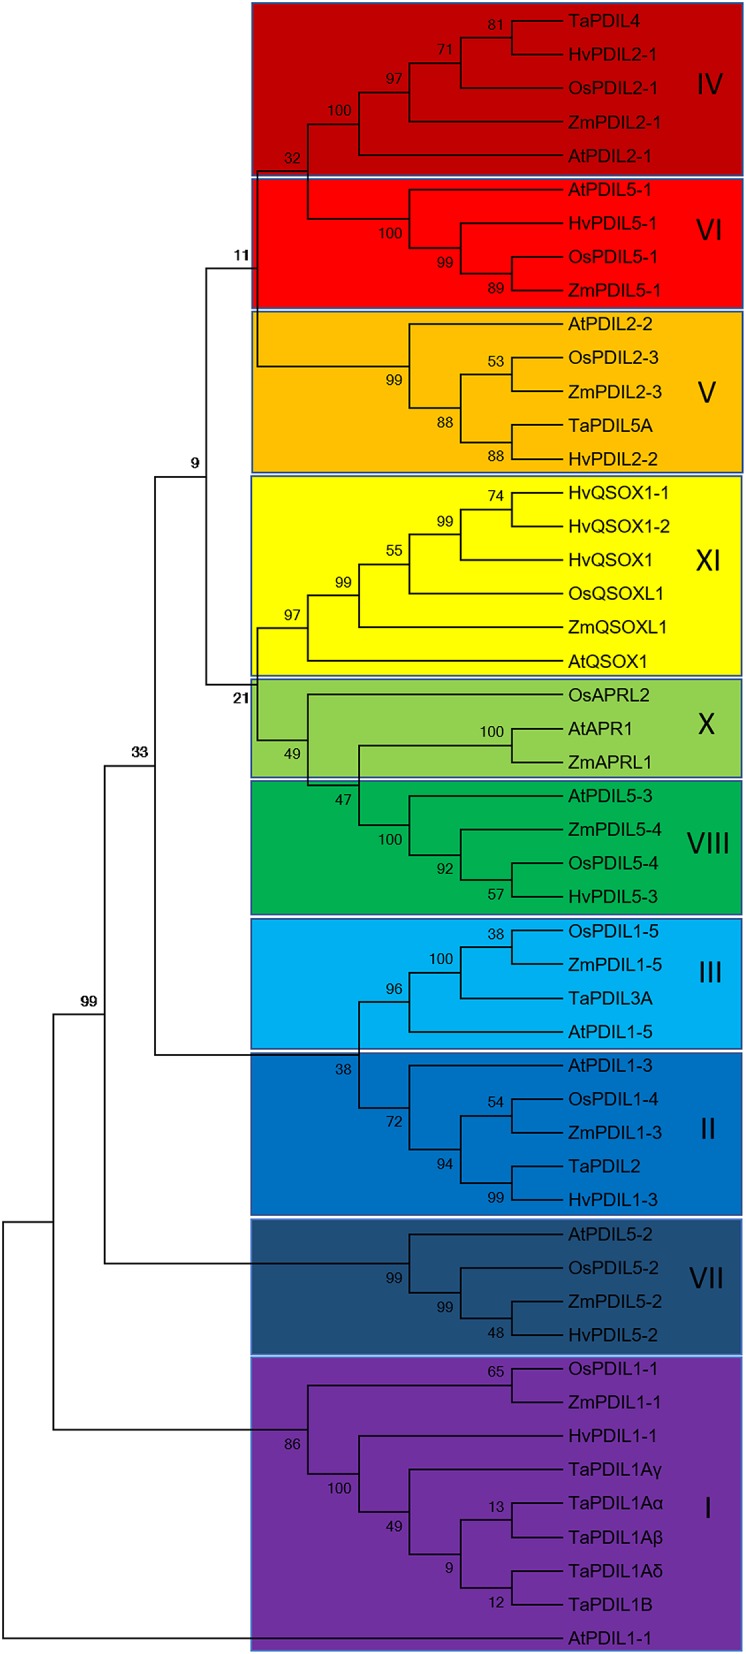
Rooted phylogenetic tree of Arabidopsis (At), Oryza sativa ssp. japonica (Os), Zea mays (Zm), Triticum aestivum (Ta) and Hordeum vulgare (Hv) PDI proteins resulting from neighbor-joining analysis of protein sequences using MEGA7.0.21 (Kumar et al., 2016). The 10 phylogenetic groups are indicated by the colored boxes. AtPDIL1-1 was used as an outgroup.